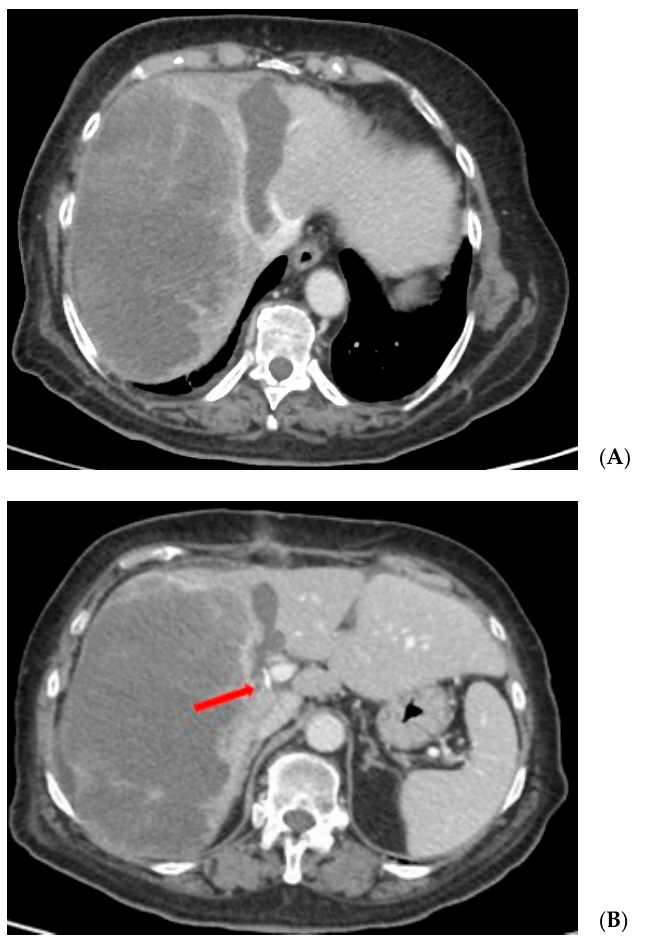
Figure 2. ( A ) CT scan after Stage 1 of RALPPS procedure showing the ablated future transection line. ( B ) CT scan after Stage 1 of RALPPS procedure showing the sectioned right portal vein (red arrow) .